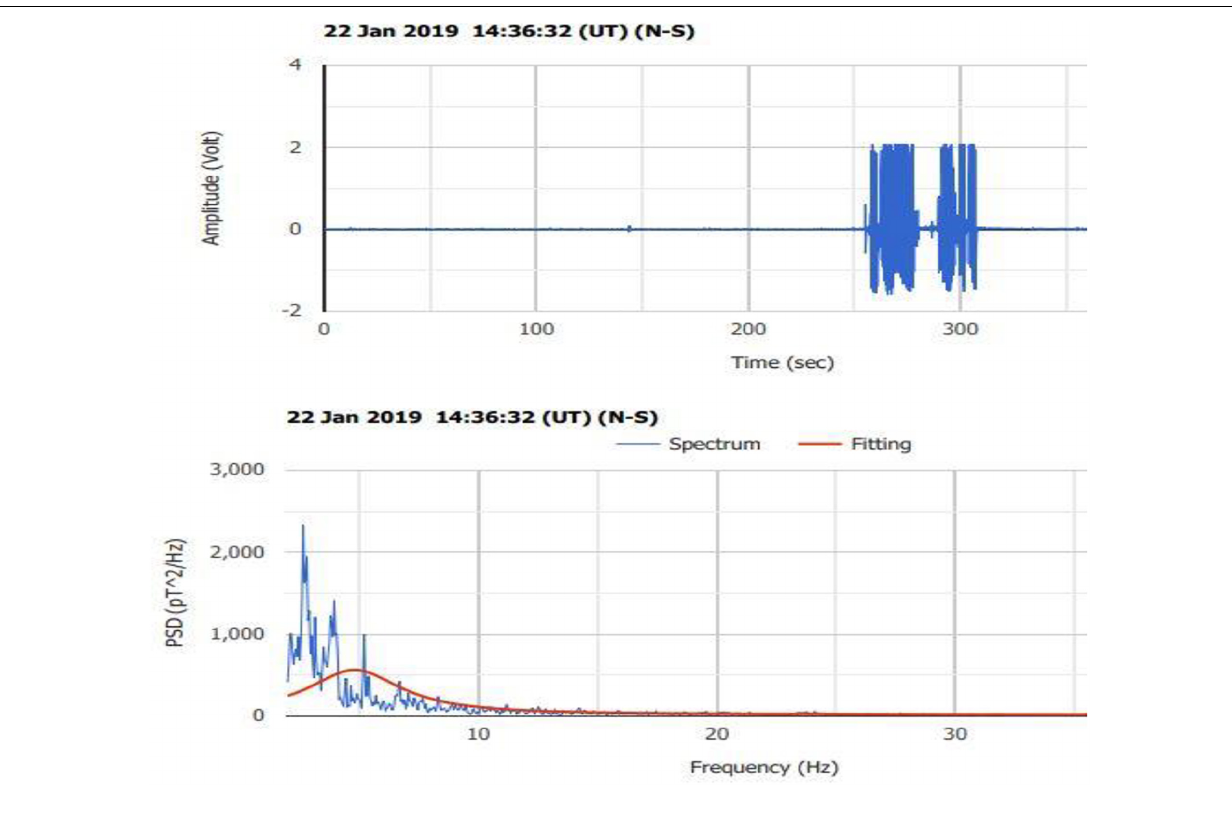
FIGURE 14 | Additional vibration by